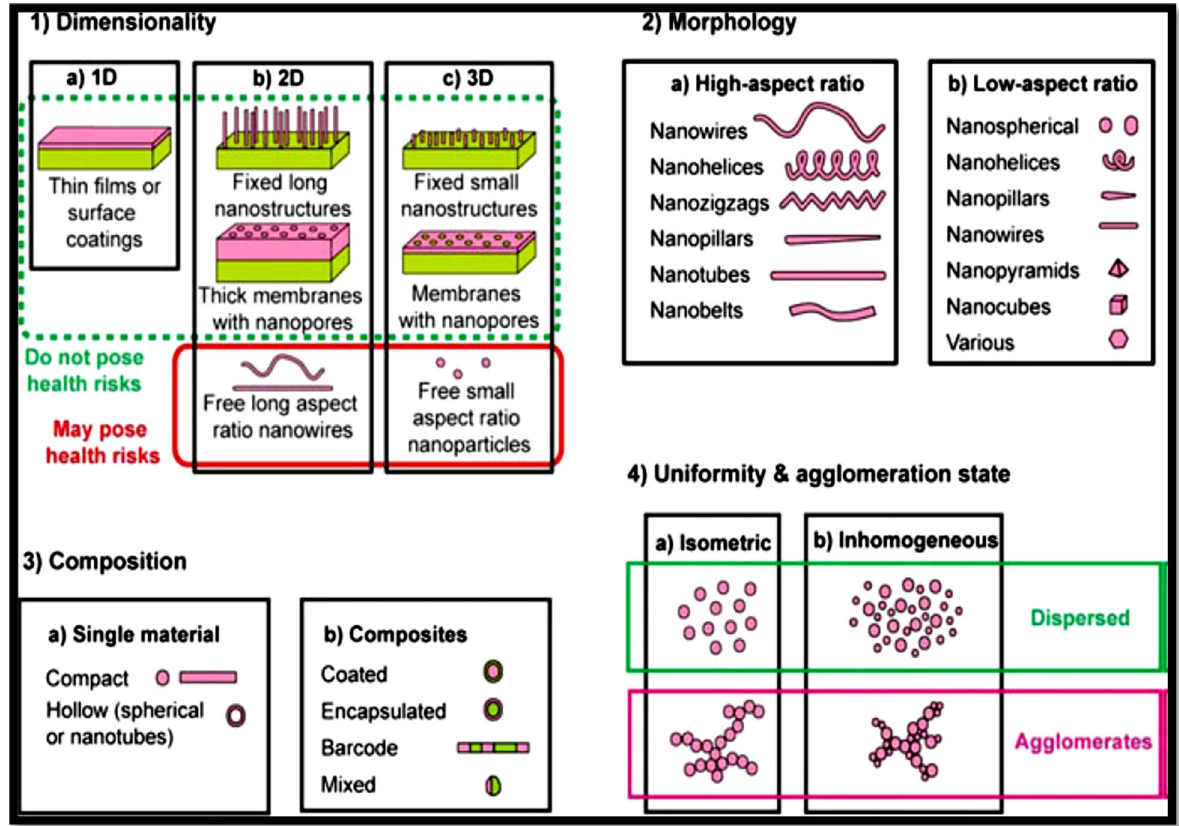
Fig. 1 Classification of nanostructured materials based on their morphology, dimensionality, composition, uniformity, and agglomeration state (Baig et al.